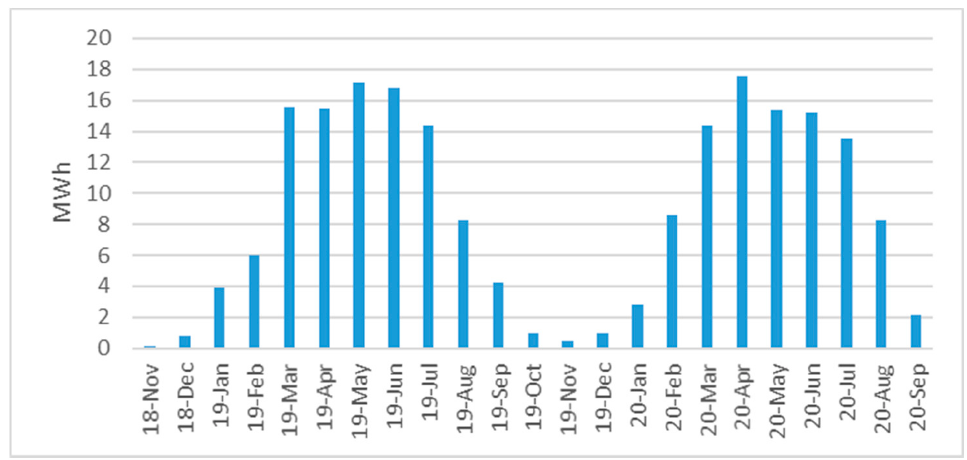
Figure 2. Real PV system electricity production capacity.